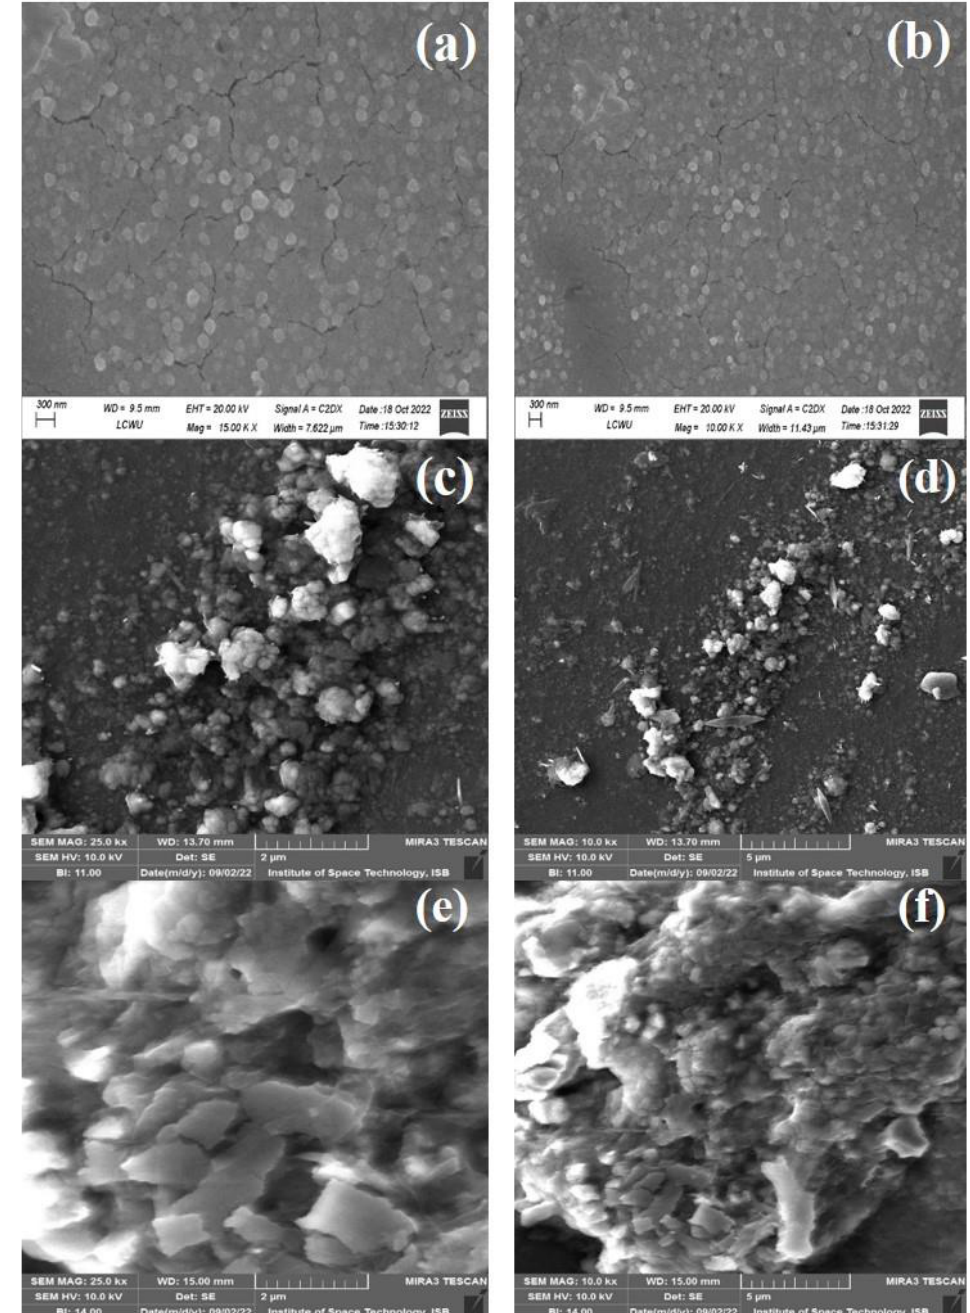
Figure 8. SEM microscopy of ( a , b ) CdS, ( c , d ) TiO 2, and ( e , f ) TiO 2 :CdS thin films.